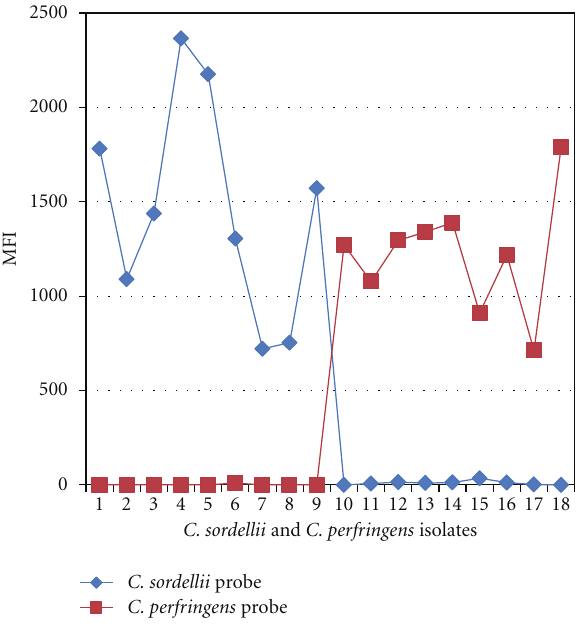
Figure 1: Identification of C. sordellii and C. perfringens isolates by the microsphere assay. Isolates 1–9: C. sordellii isolates. Isolates 10–18: C. perfringens isolates. Note higher MFI values/signals of C. sordellii and C. perfringens probes for the respective isolates only, indicating specificity of the probes.